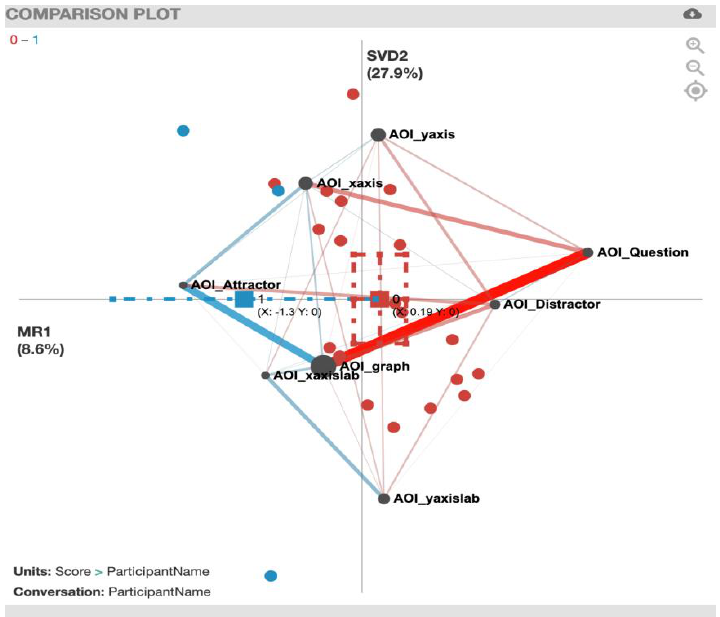
Figure 8 . PhyAreaQuant transitions with incorrect solvers (red) and correct solvers (blue). Figure 8. PhyAreaQuant transitions with incorrect solvers (red) and correct solvers